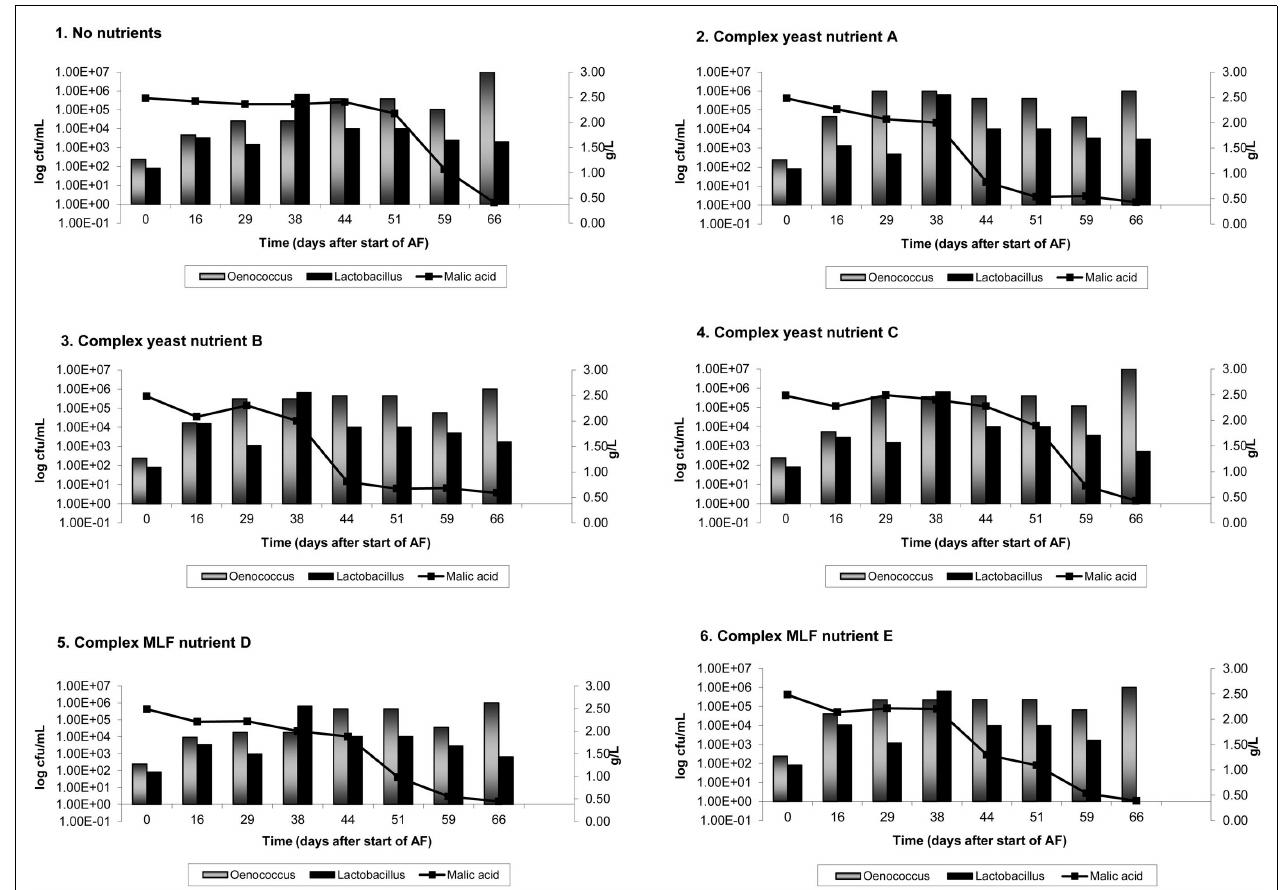
FIGURE 1 | Malolactic fermentation (MLF) (malic acid degradation) and growth of lactic acid bacteria in Cabernet Sauvignon wines. Results are the average of duplicate treatments. AF = alcoholic